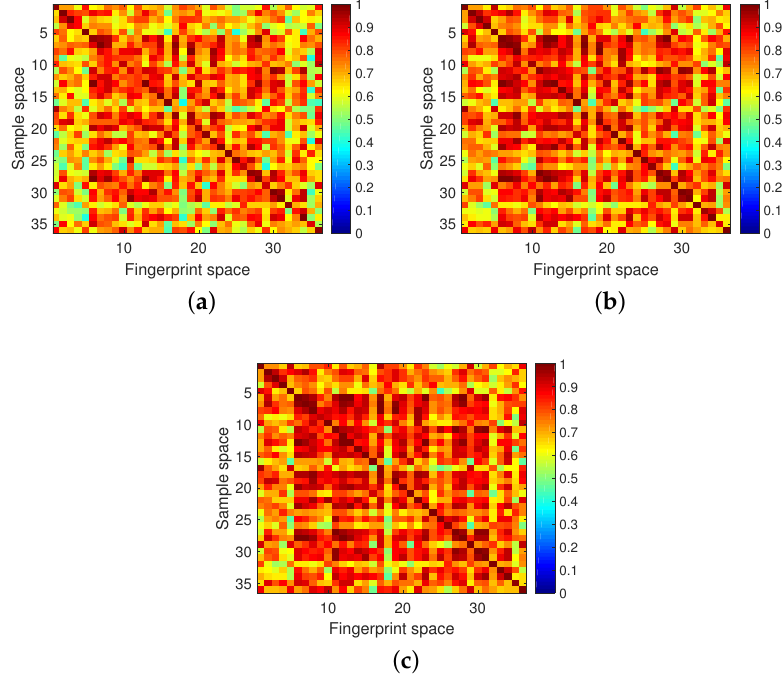
Figure 13. Competitor 1’s localization results. ( a ) One fingerprint for each location. ( b ) Four fingerprints for each location. ( c ) 10 fingerprints for each location.